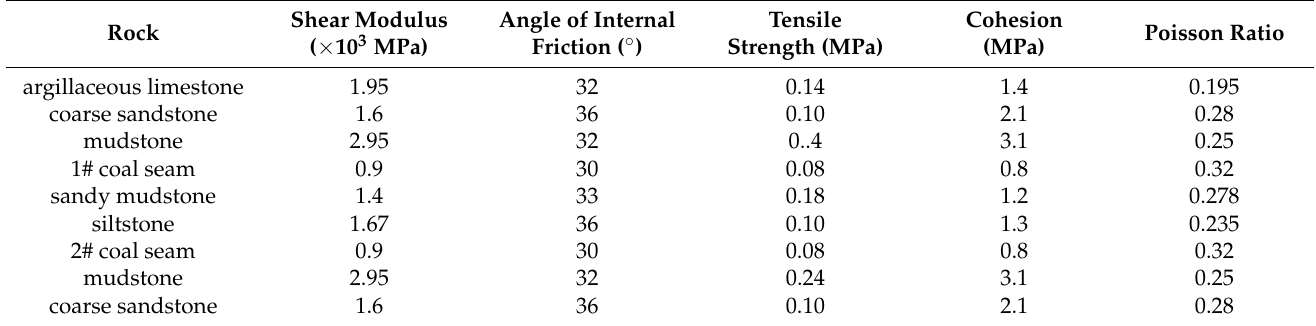
Table 3. Experimental physical and mechanical parameters of coal and rock layers.